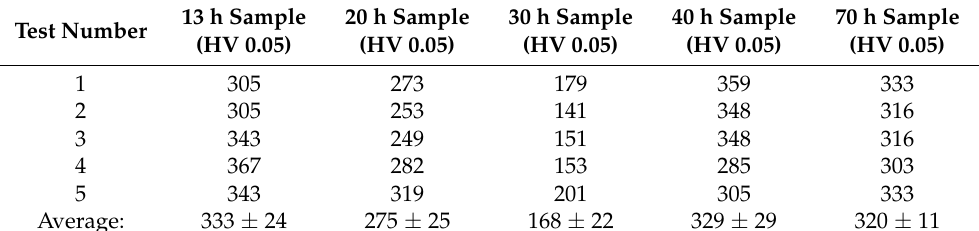
Table 2. Hardness value with error bars for samples obtained for 13, 20, 30, 40, and 70 h of milled time.